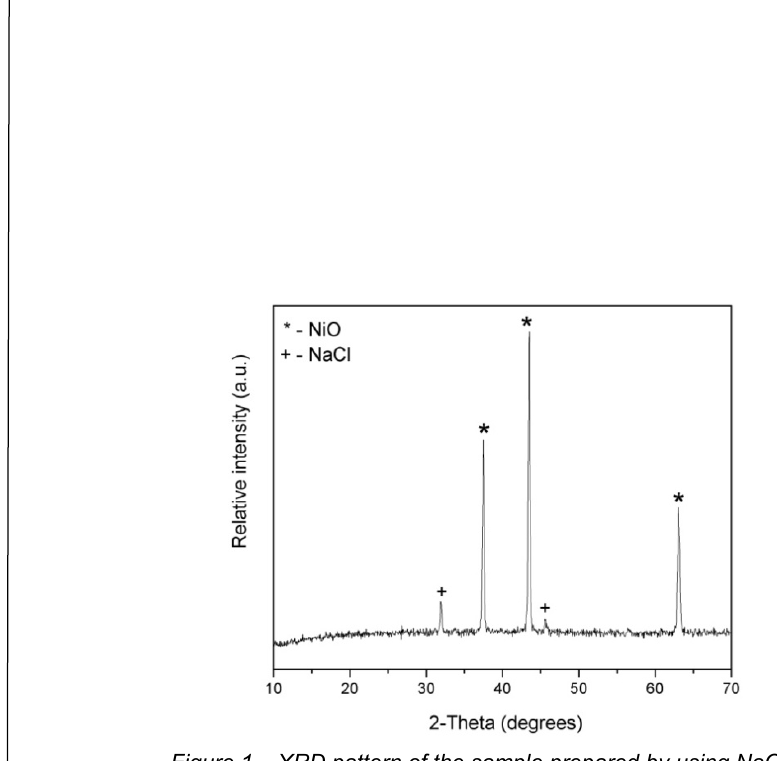
Figure 1 – XRD pattern of the sample prepared by using NaOH Рис . 1 – Дифрактограмма образца , подготовленного при использовании NaOH Слика 1 – Дифрактограм узорка припремљеног коришћењем